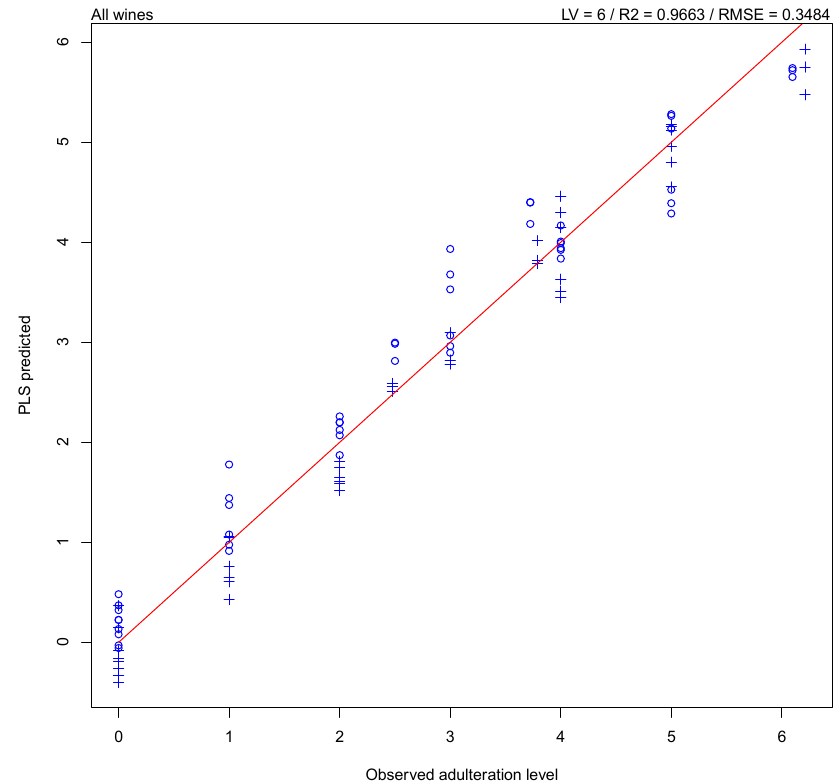
Figure 5. PLSR prediction of adulteration level for Portugieser (o) and Sauvignon Blanc (+) wine samples.